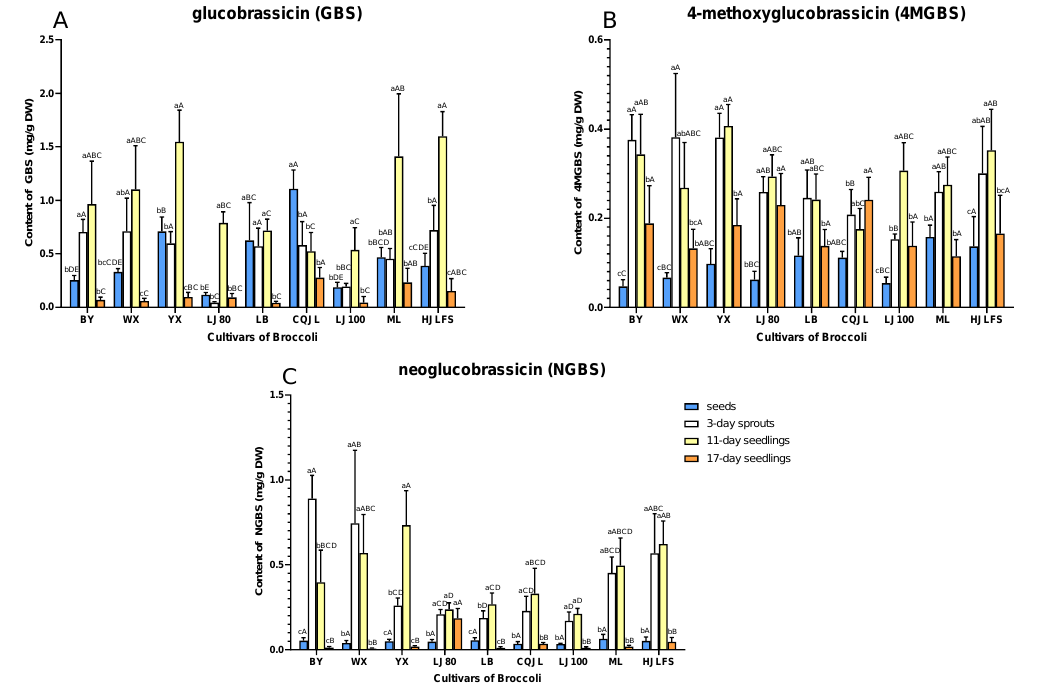
Figure 4. Contents of indole GLs in different cultivars of broccoli at various developmental stages. ( A ), Glucobrassicin (GBS); ( B ), 4-Methoxyglucobrassicin (4MGBS); ( C ), Neoglucobrassicin (NGBS). The different lowercase letters indicated significant differences ( p < 0.05) in values in different stages in the same cultivar. The different uppercase letters indicated significant differences ( p < 0.05) in values in cultivars in the same developmental stage. Values are expressed as mean ± standard deviation (SD) (n = 5) .